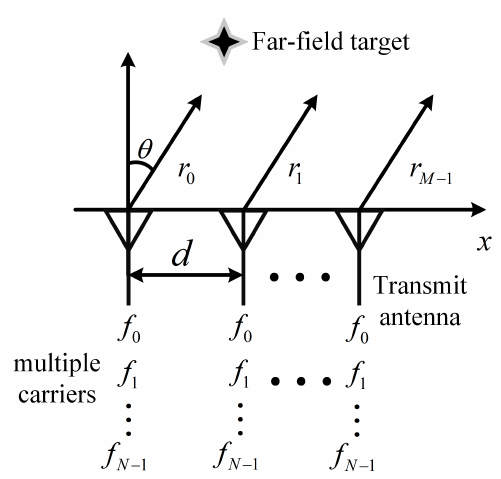
Figure 2. The schematic diagram of multi-carrier frequency diverse